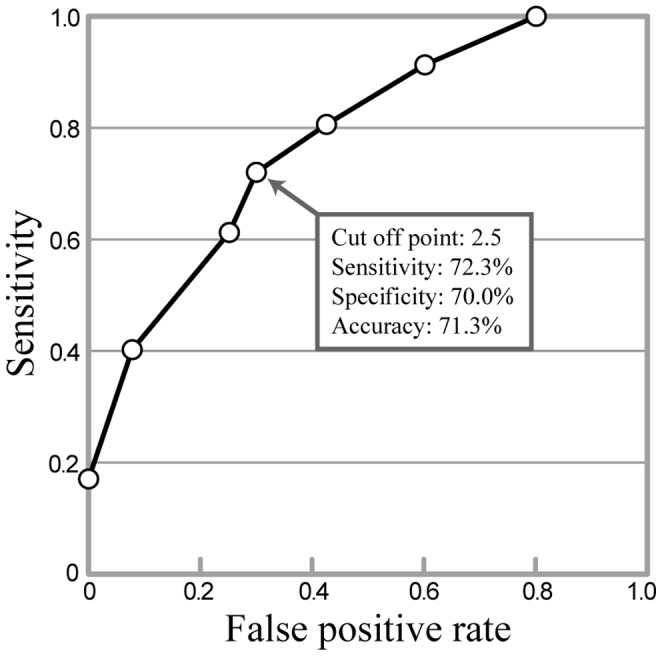
Receiver operating characteristic (ROC) validation of Lower QLD/Upper QLD.ROC validation of Lower QLD/Upper QLD revealed that a cut-off point of 2.5 yielded 72.3% sensitivity, 70% specificity, and 71.3% accuracy in the differentiation of COPD patients and healthy smokers.